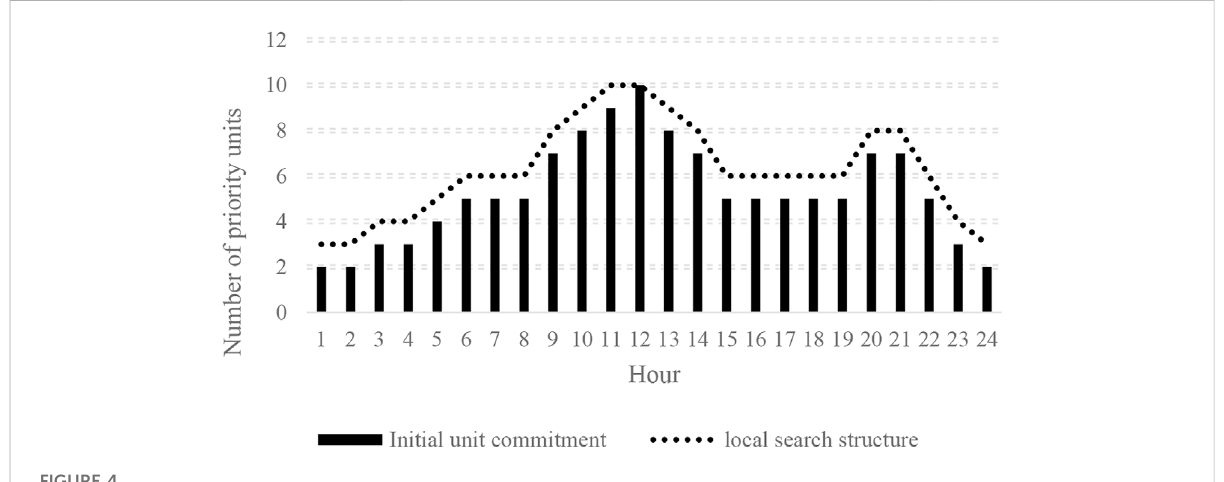
FIGURE 4 Initial unit commitment and their primary local search.